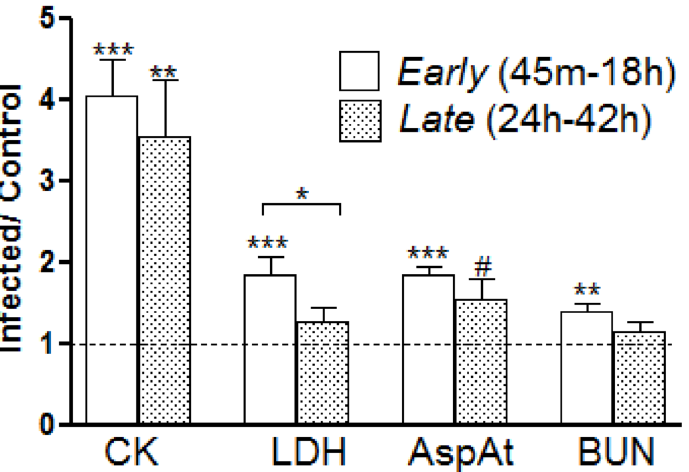
Fig 5. Longitudinal profile of plasma chemistry. The expressions of selected chemicals (Exposed/ Controls) are shown. The values measured from 45 m to 18 h were pooled together as the Early group (white bar) and those from 24 h to 42 h were clustered as the Late group (shaded bar). The horizontal broken line depicts the control value calculated from the blood samples drawn 24 h before aerosol exposure. Welch ’ s t- test computed: # 0.1 < p < 0.05, * p < 0.05, ** p < 0.001, *** p <